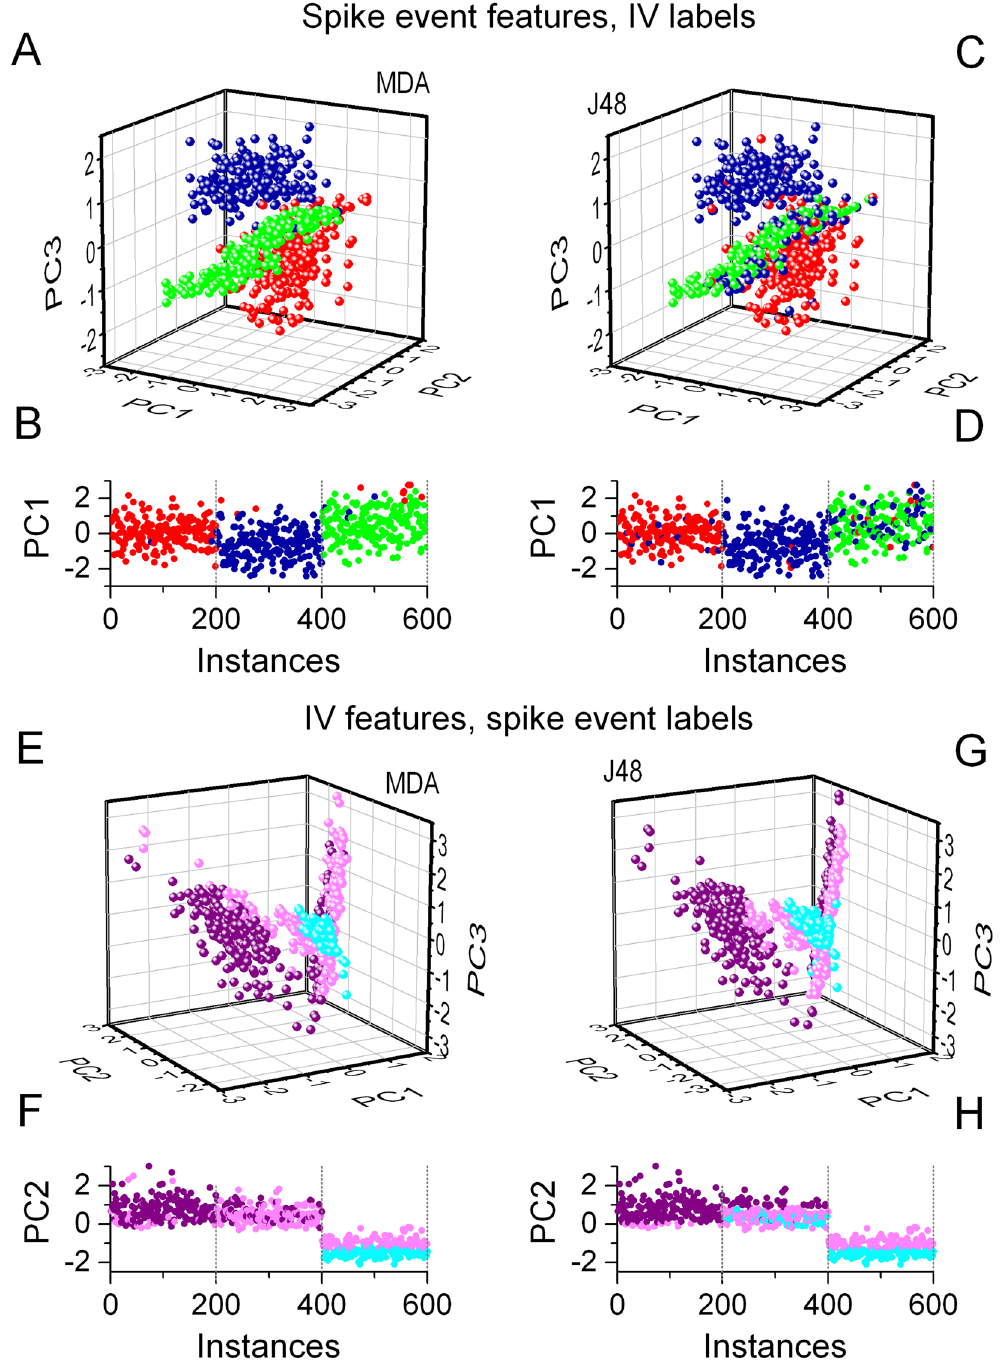
Figure 7. Supervised classification algorithms of model cells based on their spike event reliability perform well when labels from the IV responses are used as training set. Here, the MDA and J48 methods classify the model cells into 3 clearly separate classes ( A,C ) very well reproducing the distribution of the biophysical phenotypes ( B,D ). Conversely, when the training dataset from the spike event data is used to classify the IV feature vectors, the two methods identifies groups that represent the qualitatively different type A , B and C firing patterns. ( E – F ) MDA method, ( G – D )